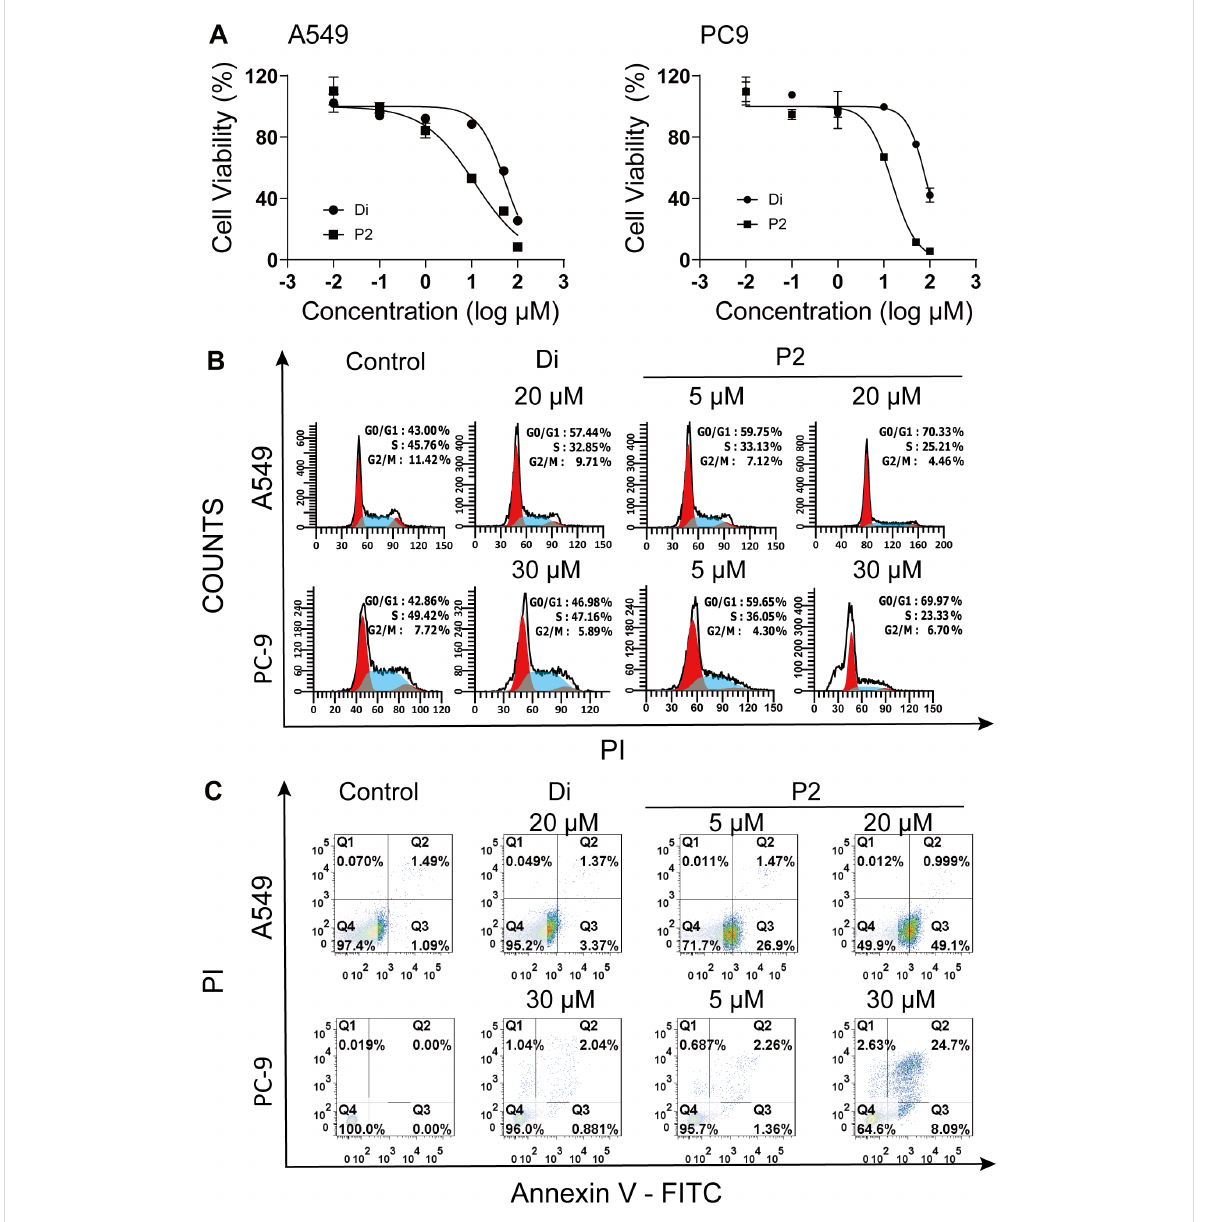
Figure 2: In vitro anticancer activity of diosgenin (Di) and its derivative FZU-0021-194-P2 (P2). (A) The antiproliferative activities of different concen- trations of Di and P2 against A549 and PC9 cells for 48 h. (B) Cell cycle analysis of A549 and PC9 cells after treated with Di and P2 for 48 h. (C) Cell apoptosis analysis of A549 and PC9 cells after treated with Di and P2 for 48 h.